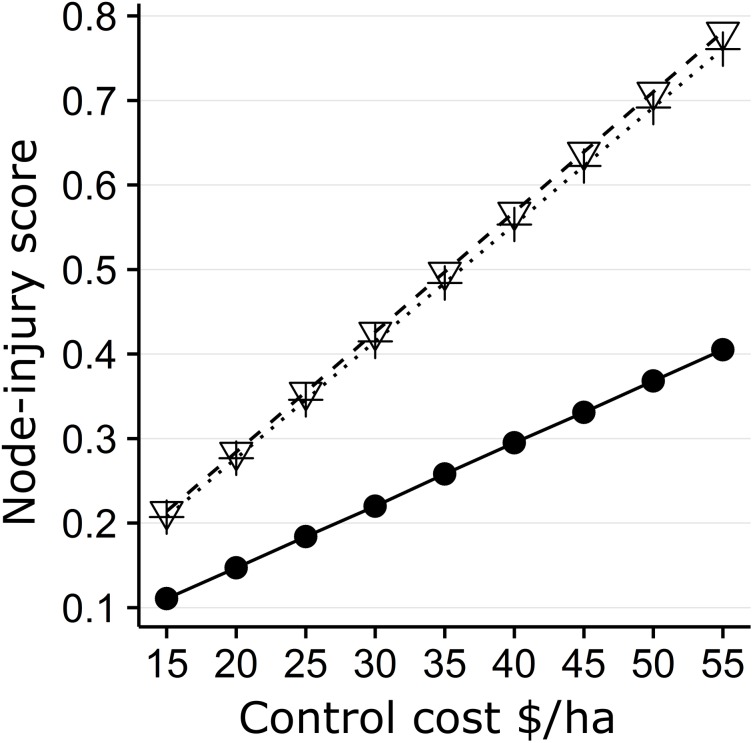
The minimum node-injury score required to cause economic damage calculated according to the Oleson et al. (2005) moderate environmental stress model.2014 and 2015 are represented as an inverted triangle with dashed lines and crosses with dotted lines respectively. 2012 price data is included to show how recent (five year) high commodity values affect economic thresholds and is represented as a filled circle with solid lines.